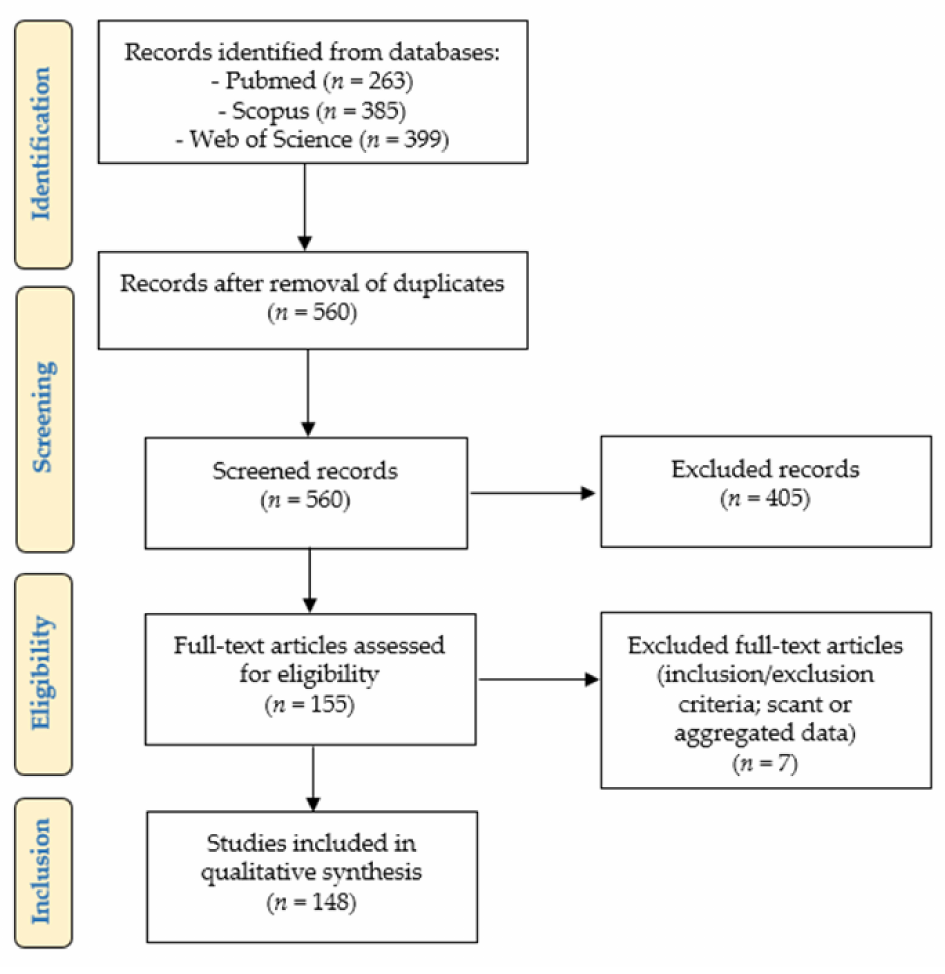
Figure 1. Systematic review of the literature: PRISMA